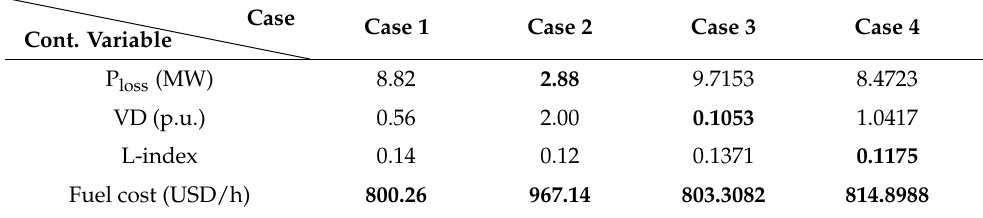
Table 5. Fitness functions for Cases 1–4.